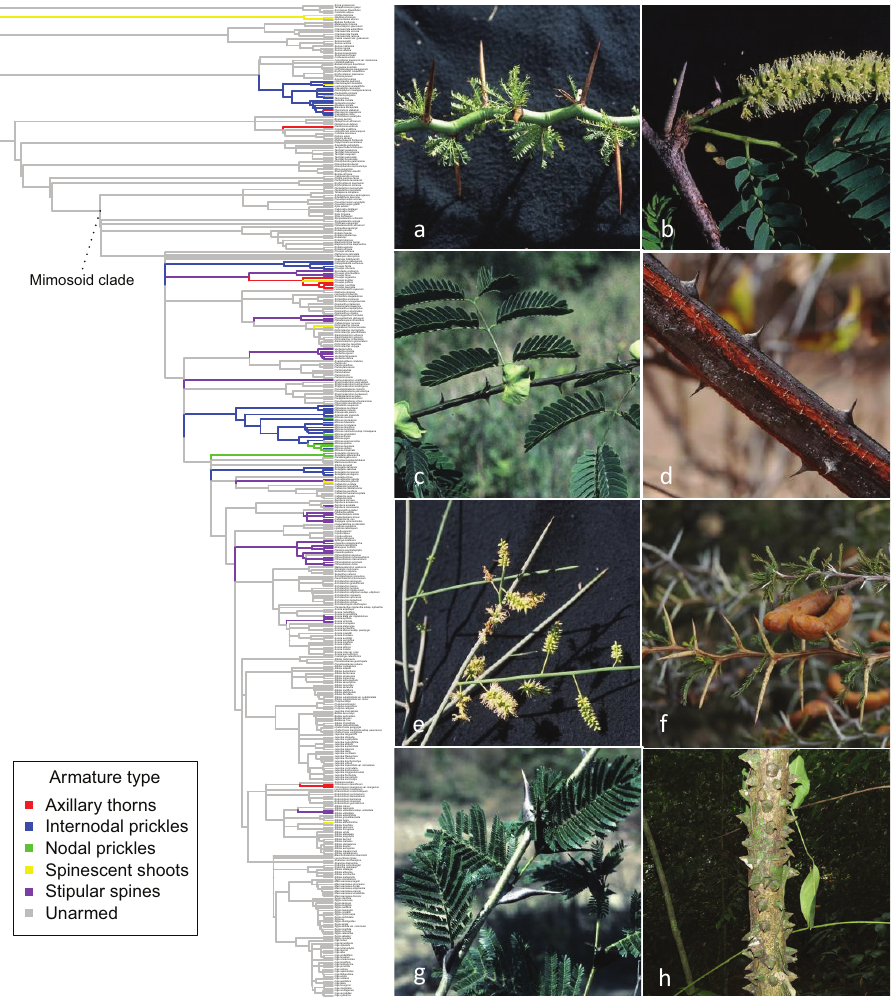
Figure 15. Evolution of different types of armature across Caesalpinioideae. Character states were de- fined as: unarmed ; nodal or internodal prickles on stem ; stipular spines ; nodal axillary thorns including modi- fied inflorescence axes of Chloroleucon ; spinescent shoots . Branch lengths are not informative in this figure. Photos a and b axillary thorns a Parkinsonia andicola (Griseb.) Varjão & Mansano b Prosopis juliflora (Sw.) DC. c, d, h internodal prickles c Senegalia tamarindifolia (L.) Britton & Rose d Mimosa ophthal- mocentra Mart. ex Benth. e spinescent shoots, Prosopis kuntzei Harms f and g stipular spines f Prosopis ferox Griseb. g Vachellia cornigera (L.) Seigler & Ebinger h Cylicodiscus gabunensis Harms. All photos Colin Hughes, except h William